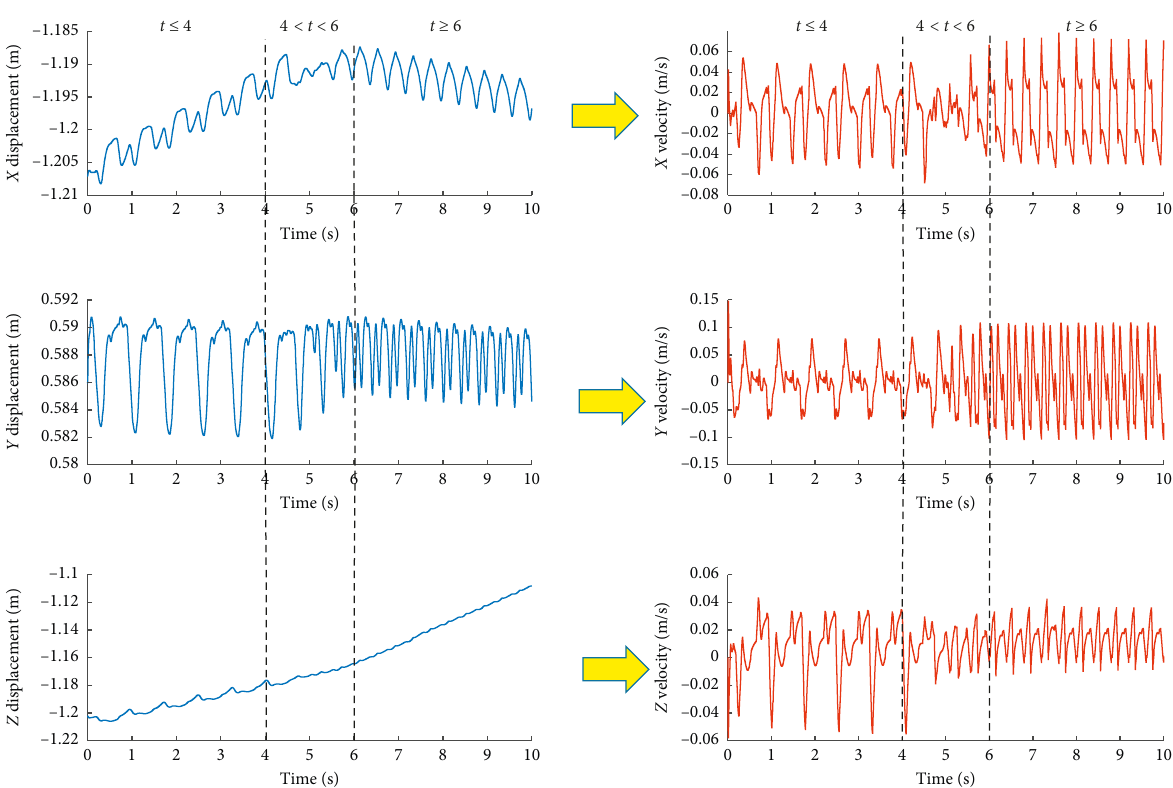
Figure 19: Displacement and speed in gait